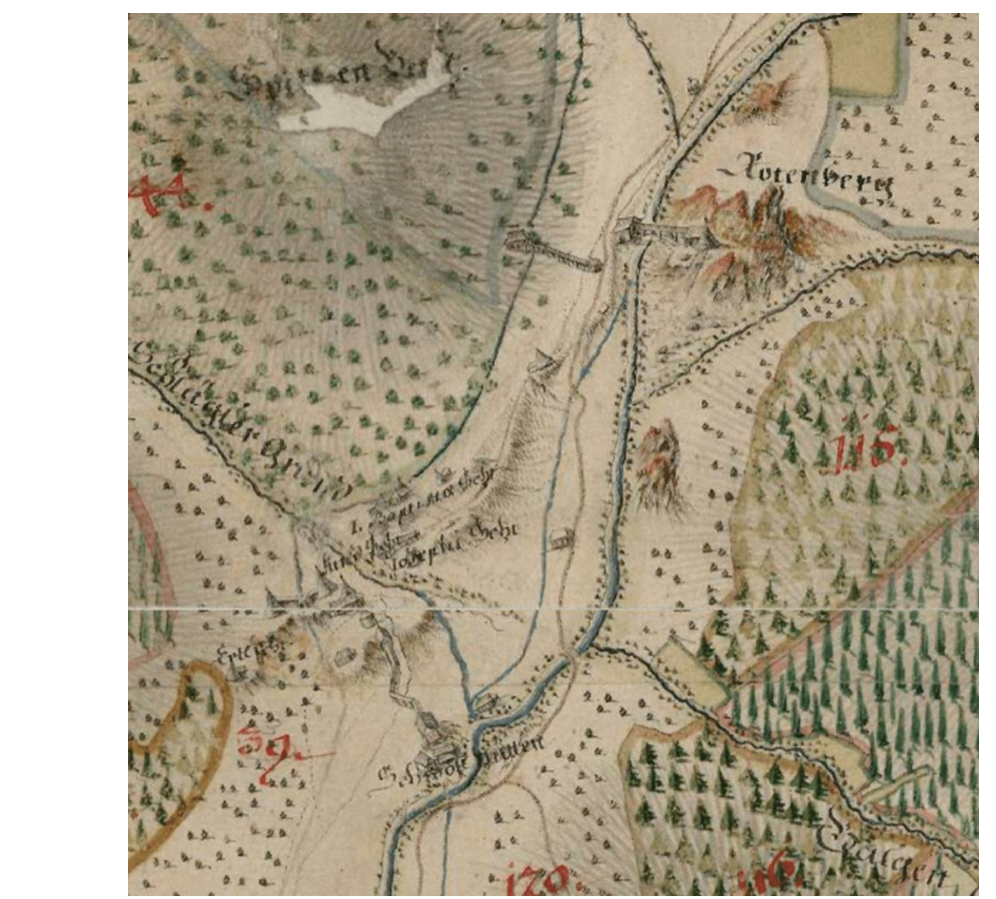
Figure 5. Technical facilities and buildings of copper cementation facilities in the Rotenberg and Spitzen Berg mining fields depicted in the map of the Smolník Chamber Estate (1774) (source: Országos, Széchényi Könyvtár, Budapest, Hungary; the copy of the map was obtained in